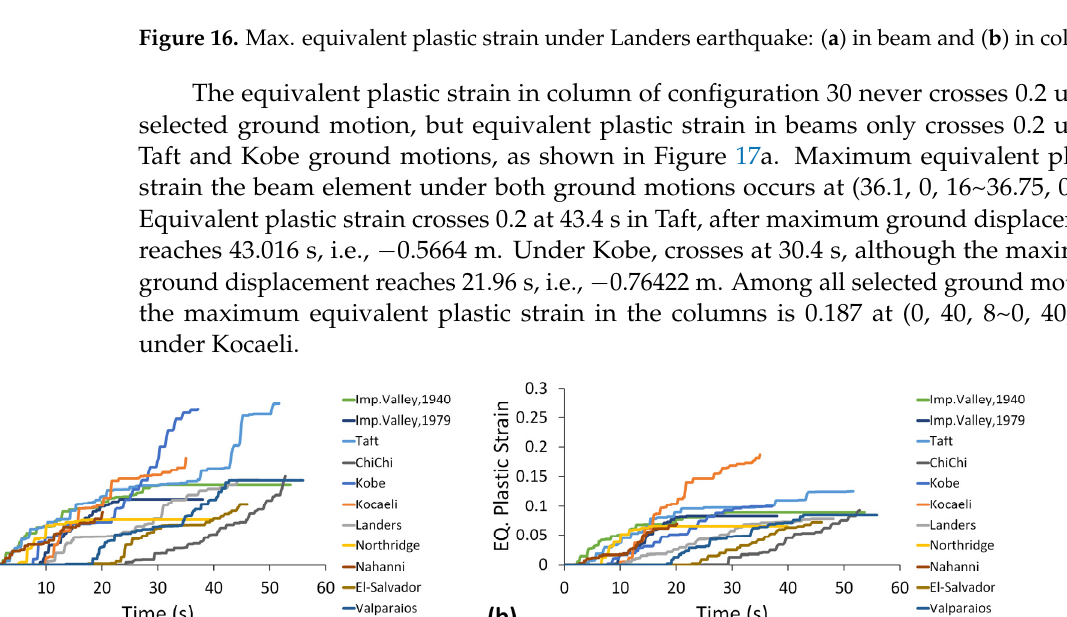
Figure 16. Max. equivalent plastic strain under Landers earthquake: ( a ) in beam and ( b ) in column.